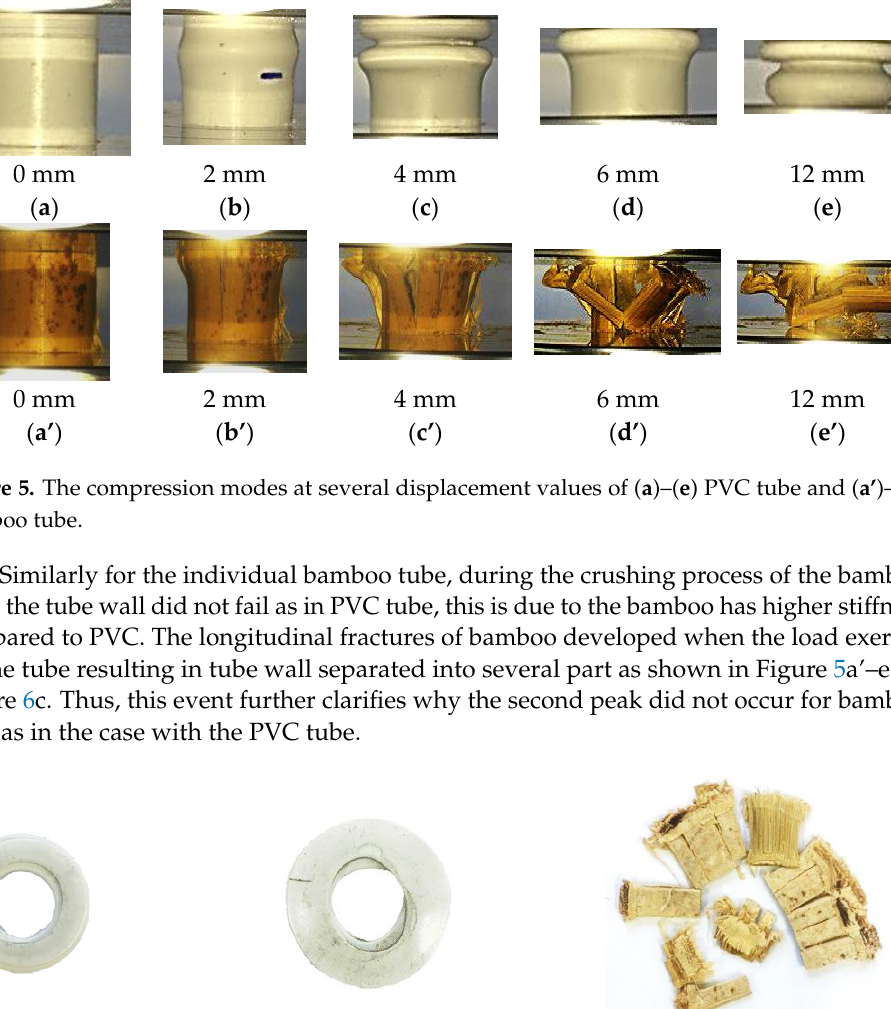
Figure 4. Load-displacement curves for three types of tube.